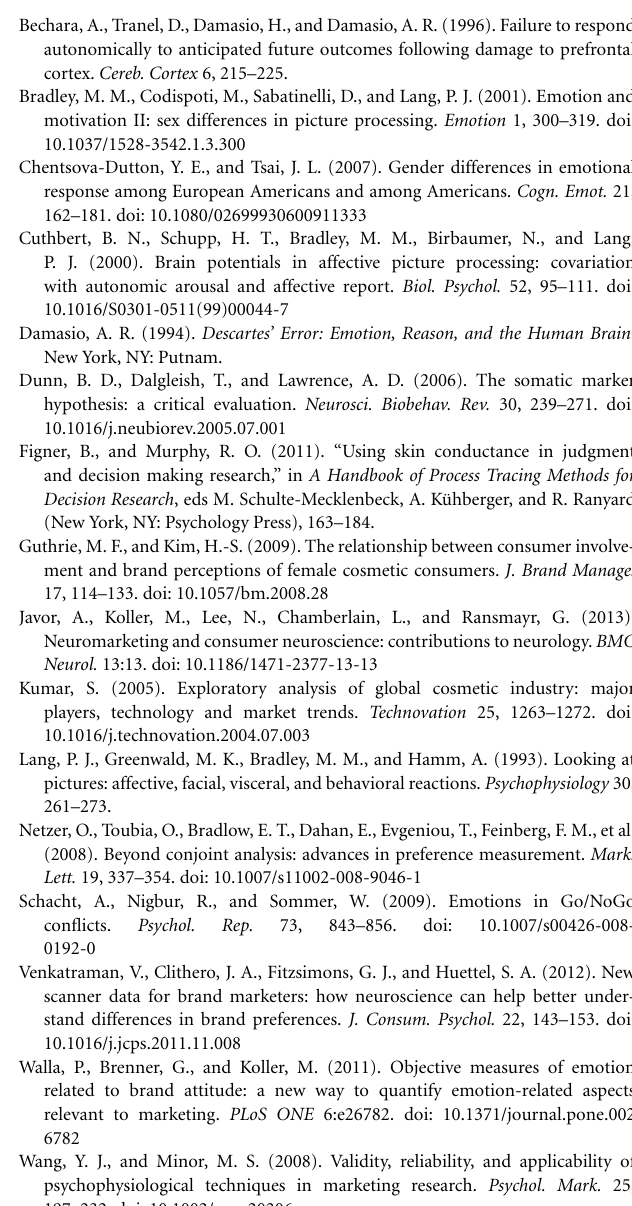
Figner, B., and Murphy, R. O. (2011). “Using skin conductance in judgment and decision making research,” in A Handbook of Process Tracing Methods